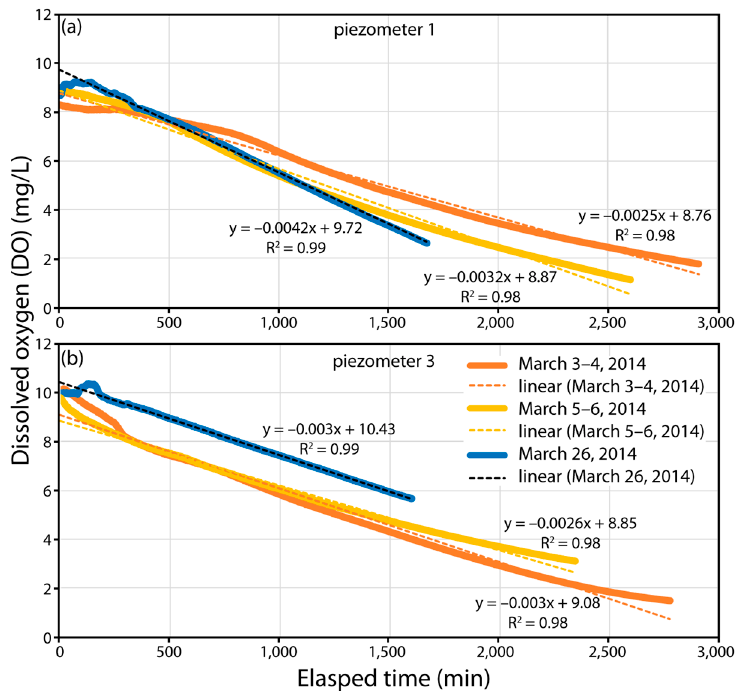
Figure 8. Dissolved oxygen (DO) depletion curves for: ( a ) piezometer 1; and ( b ) piezometer 3 for three precipitation events in March 2014. The slope of the linear fit for each DO depletion curve (mg ∙ L ‒ 1 ∙ min ‒ 1 ) is used to calculate the average slope of DO depletion curve for the LID infiltration trench.